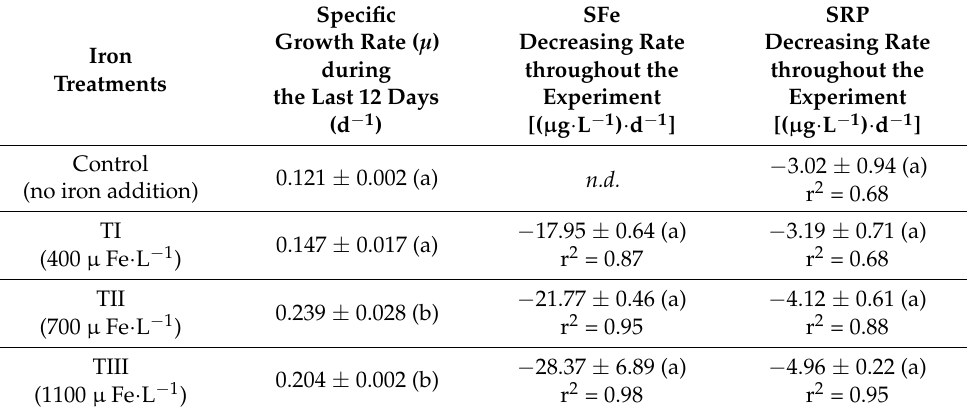
Table 3. Microcystis spp. natural samples collected from the 2017 bloom: specific growth and soluble iron decreasing rates in microcosms exposed to different iron treatments: control, without